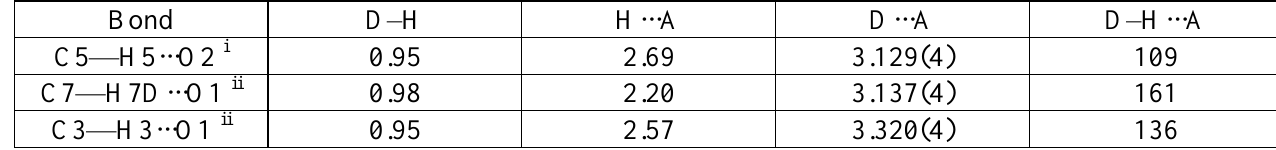
Table 1. Hydrogen-bond geometries for